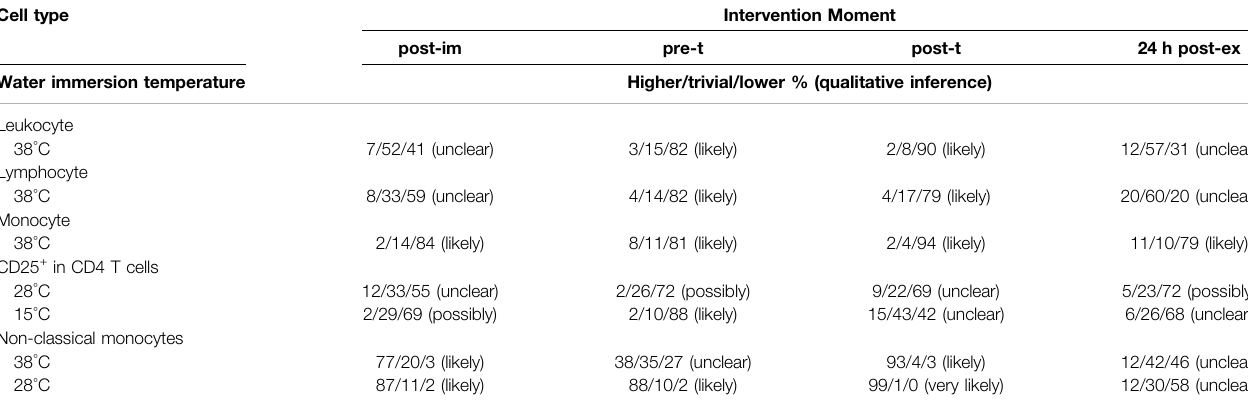
TABLE 3 | Magnitude-based inferences after recovery by hot- (38 ° C), thermoneutral- (28 ° C) and cold- (15 ° C) water immersion compared to control. Cell